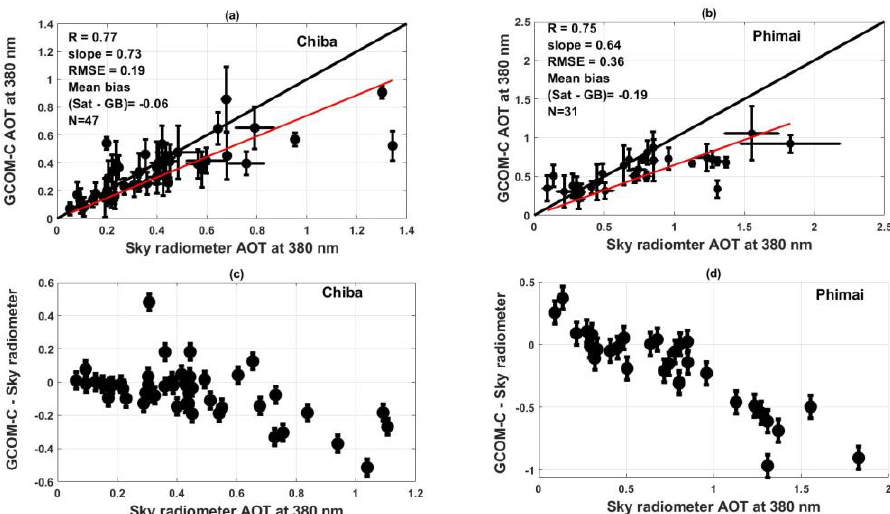
Figure 4. (top panel) The scatter plot of the sky radiometer and GCOM-C AOT at 380 nm at ( a ) Chiba and ( b ) Phimai. The GCOM-C data within 30 km centered on the sites were selected for the comparison. Only the clear sky day (based on the GCOM-C cloud flag) data are shown. For the Chiba site, GCOM-C data only over land was selected using the land-sea mask information. The red lines in the scatter plots are the least square fitted lines to the scatter plots. The black lines indicate the 1:1 line. The error bars indicate the 1σ standard deviation. (bottom panel) ( d ) The absolute differences between the coincident sky radiometer and GCOM-C observations at ( c ) Chiba and ( d ) Phimai. The error bars in ( c ) and ( d ) indicate the standard error in the differences. N indicates the number of coincident samples available for the comparison.